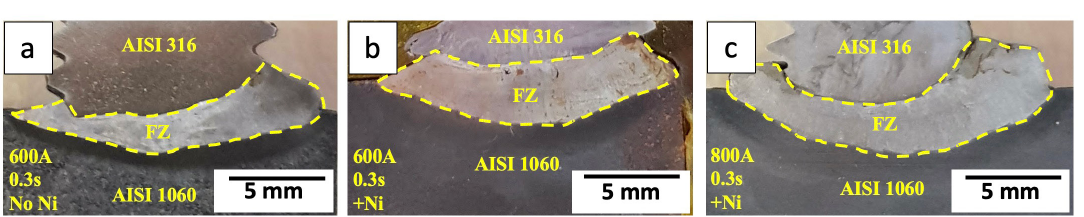
Figure 2. Macrophotography of welds (a) 600A, 0.3s and without Ni (b) 600A, 0.3s, with Ni (c) 800A, 0.3s, with Ni